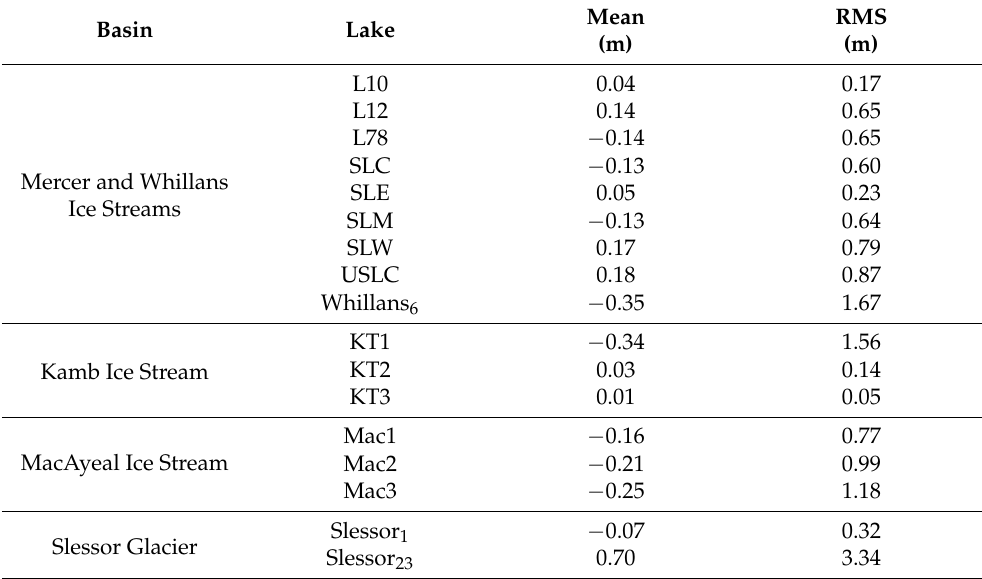
Table 1. Statistics of the biases between the CryoSat-2-based and ICESat-2-based time